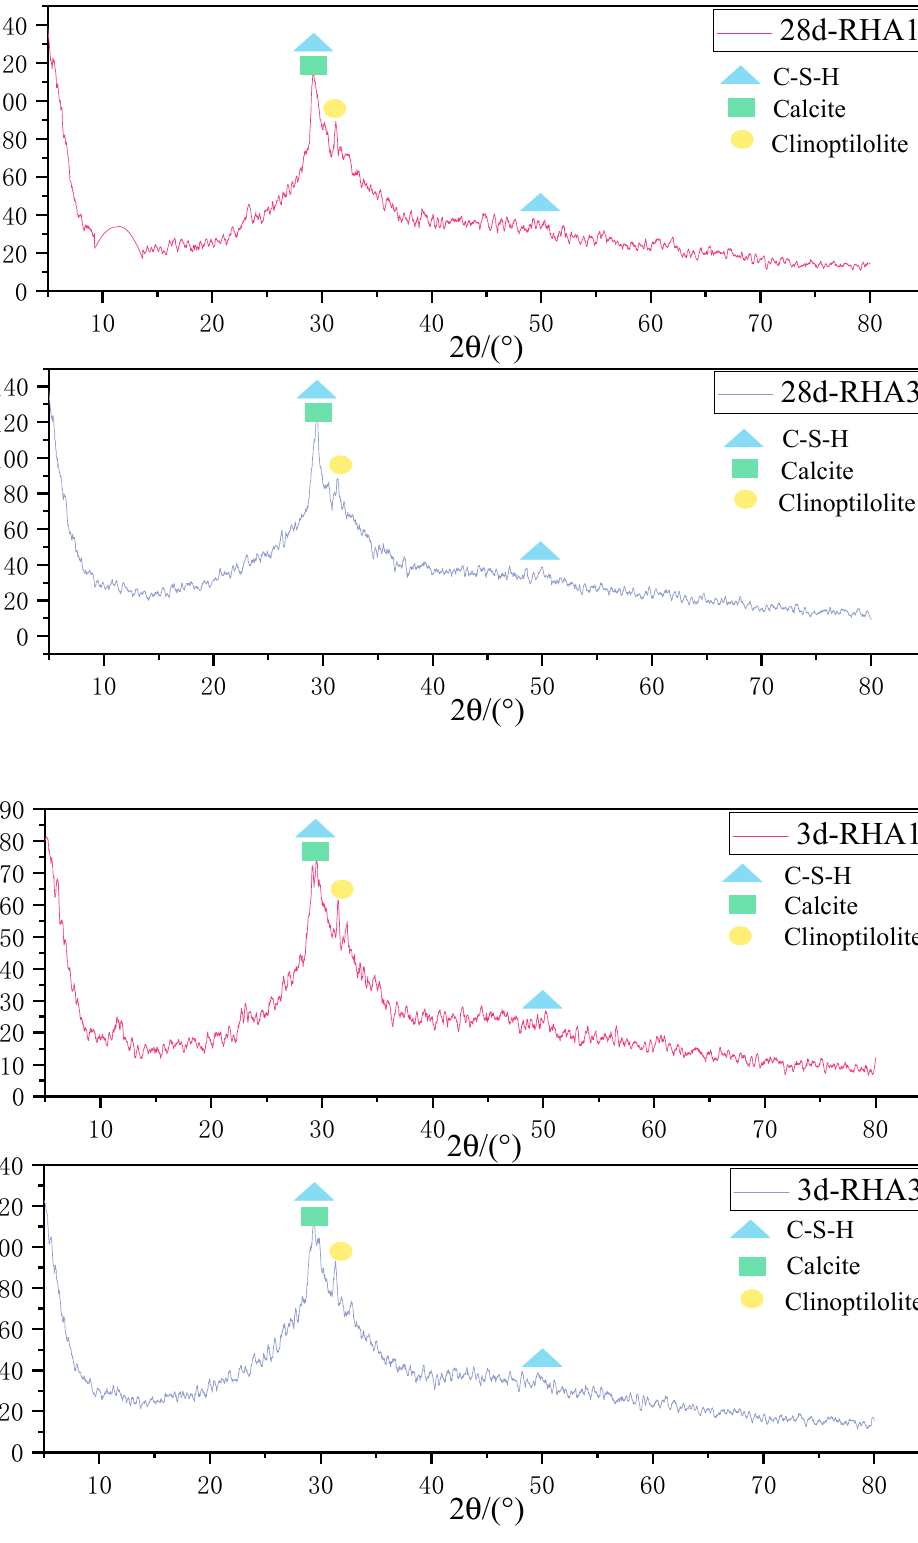
Figure 5. XRD analysis of alkali-activated GGBS slurries with different amount of RHA at 3 days and 28 days.